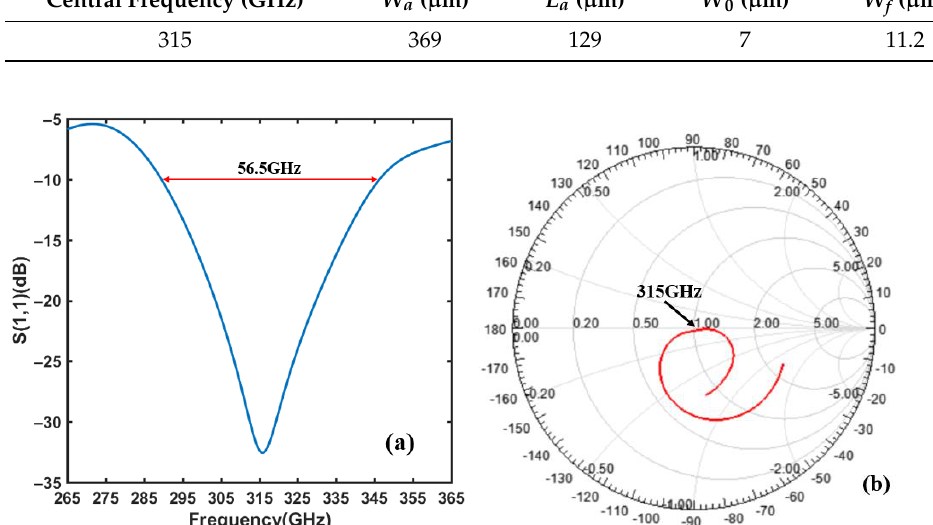
Table 1. The design parameters of a THz antenna.